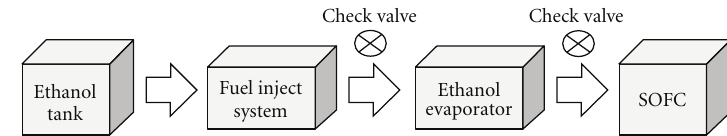
Figure 1: The diagram of the fuel injection system.